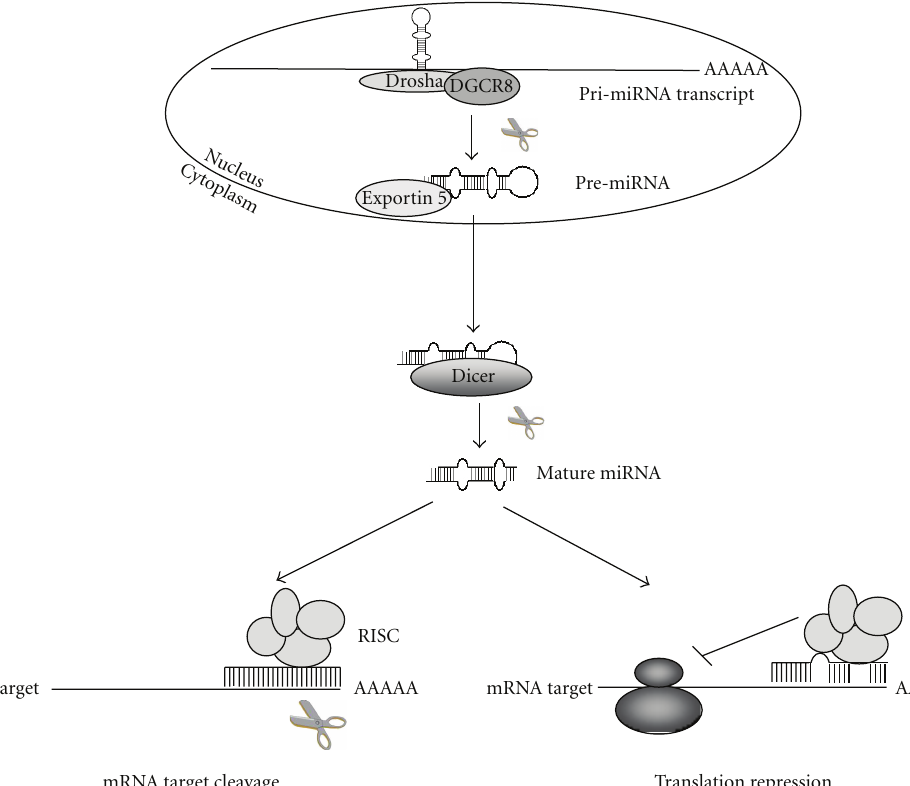
Figure 1: Model for miRNA biogenesis and functional mechanisms . miRNA genes are transcribed by RNA polymerase II (pol II) into primary transcripts (pri-miRNAs) that are cleaved by the Drosha-DGCR8 complex to 60–70 nt pre-miRNAs. Pre-miRNAs are then transported to the cytoplasm by exportin-5 and there processed by the endonuclease Dicer to generate a double-stranded mature miRNA of about 21–23 nt. After a strand selection/separation process, the mature miRNA is incorporated into the RISC complex while the other strand is degraded. RISC complex will recognize and mediate cleavage or repression of specific